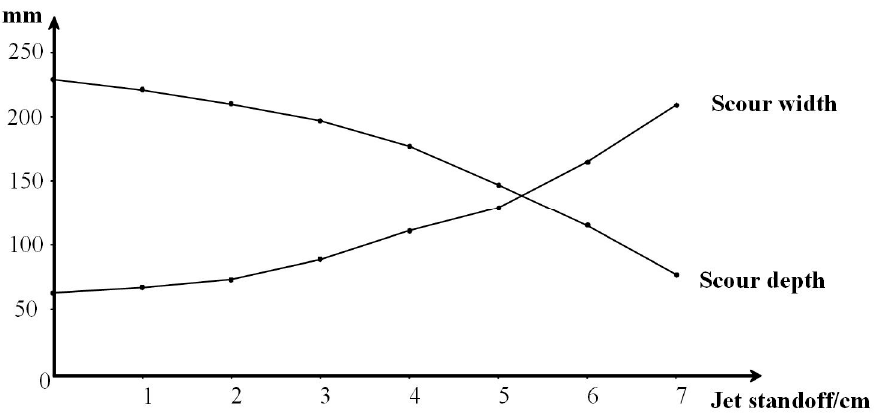
Figure 19. Scour depth and width at different standoff distances of the nozzle.